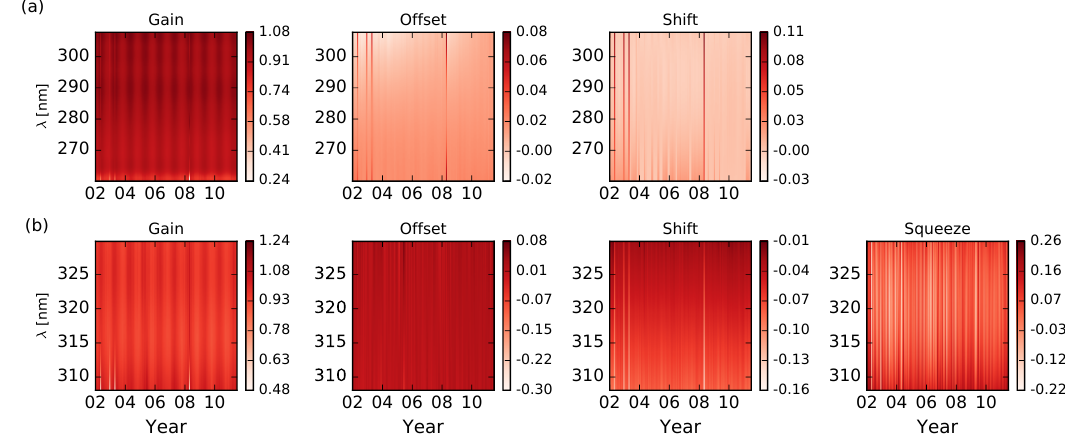
Figure 10. Temporal evolution of the slit function parameters for Channel 1 (a) and Channel 2 (b) . The time series spans the entire mission for 3466 days, between 2002 and 2012. The ranges of the parameter values are shown to the right to each subplot.